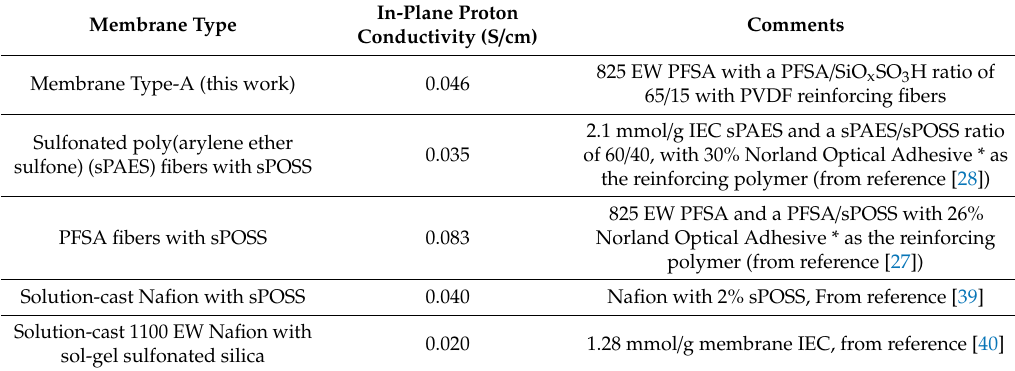
Table 7. The proton conductivity of ionomer membranes containing sol-gel sulfonated silica or sulfonated polyhedral oligomeric silsesquioxane (sPOSS). In-plane conductivities were measured at 80 ◦ C and 50% relative